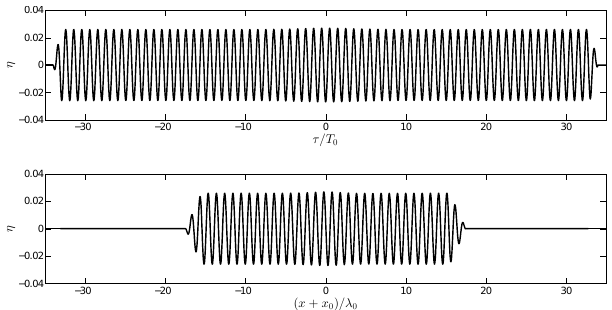
Figure 1. The prescribed initial variation of the surface eleva- tion η in the temporal (top) and spatial (bottom) domains for the carrier wave period T 0 = 0 . 8s and background carrier amplitude ζ 0 = 0 . 026m; calculated for X = − 2 . 613 ( x 0 = 31m) in Eq.